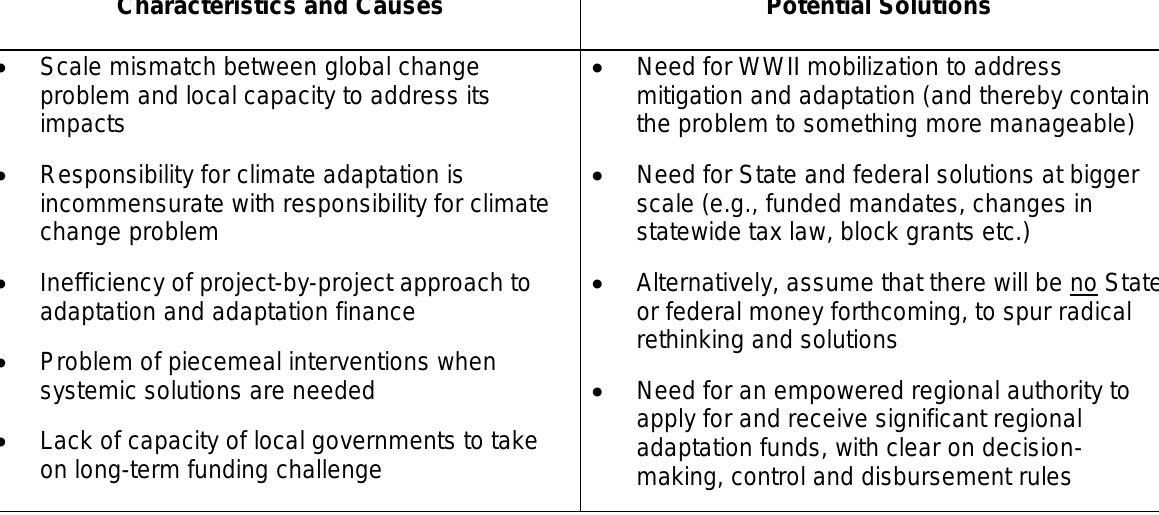
Table A2.5: Characteristics, Underlying Causes and Potential Solutions to Address the Inappropriate Funding Scale